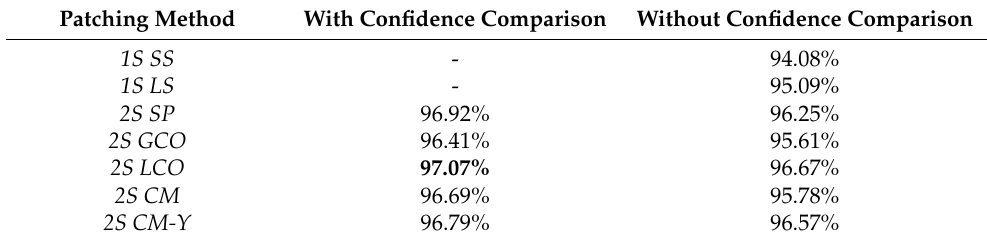
Table 4. Median accuracy calculated over 30 iterations on the test datasets for the different approaches. The methods using an additional LCO patching were configured with the best patch size stated in Table 3.